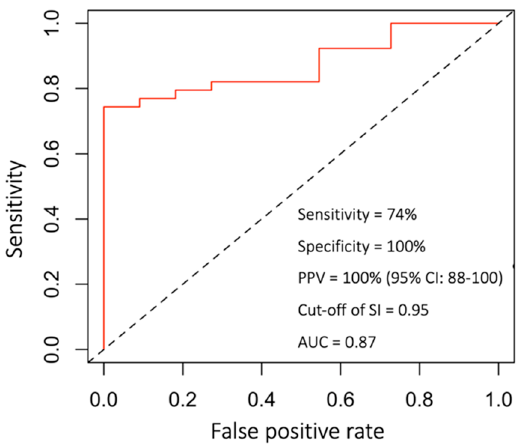
Figure 4. ROC curve of shock index and prediction of angioembolization. Cutoff value of SI, 0.95;